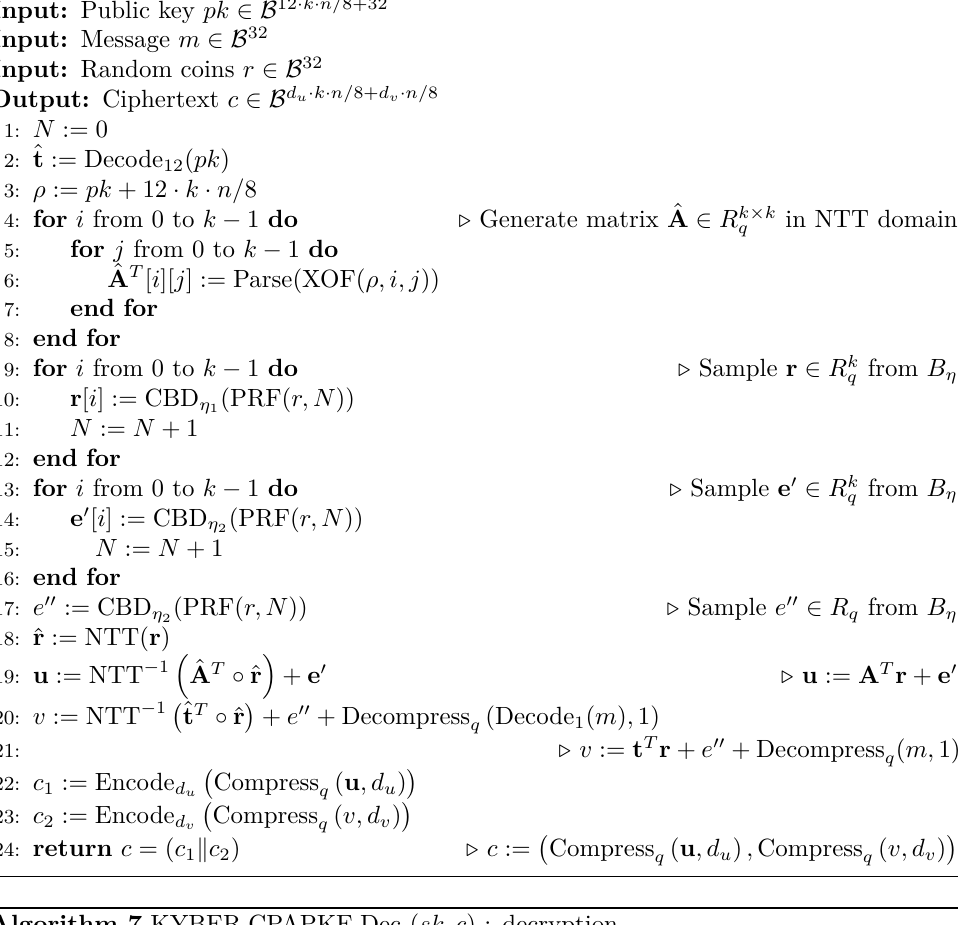
Algorithm 6 KYBER.CPAPKE.Enc ( pk, m, r ) : encryption